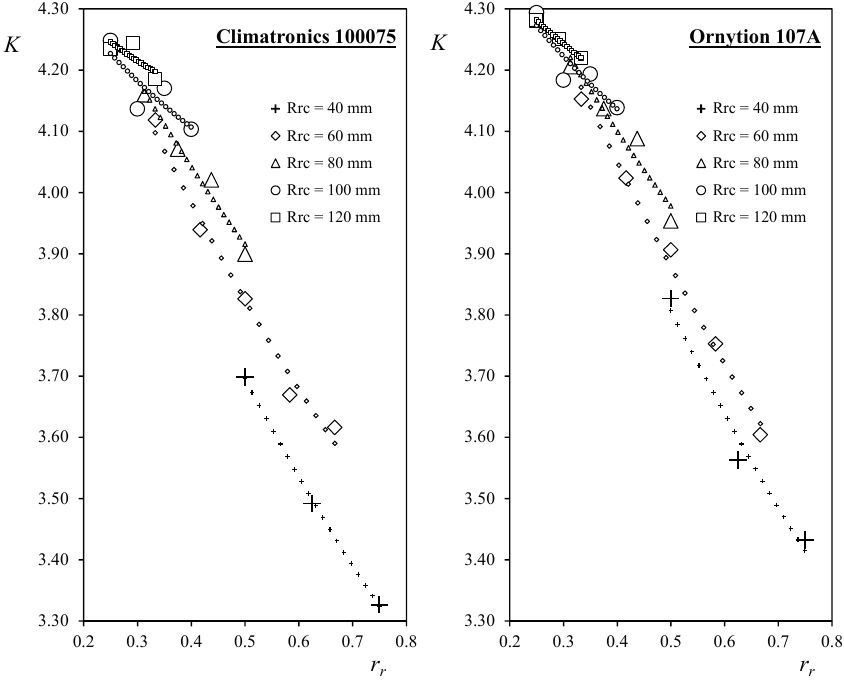
Figure 10. Anemometer constant, K , plotted as a function of the ratio r r , from multiple calibrations performed on Climatronics 100075 and Ornytion 107A cup anemometers, equipped with different conical-cup rotors (see picture in Figure 9). Results of the 2-cup analytical model implemented with non-constant aerodynamic load distribution on the cups are also included in the plots (small